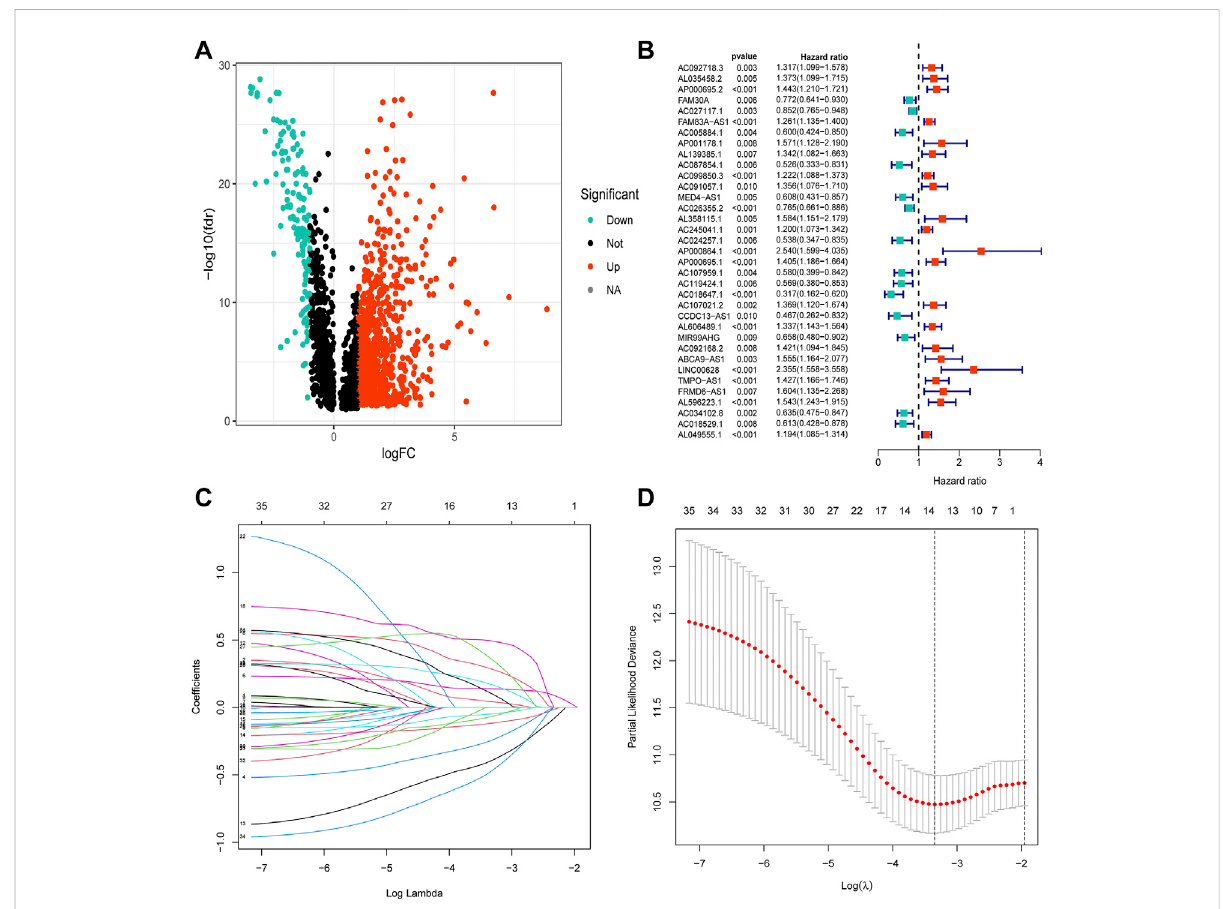
FIGURE 2 Construction of the necroptosis-related lncRNA prognostic signature. (A) The volcano diagram of 968 differentially expressed necroptosis- related lncRNAs. Red and blue colors represent upregulated and downregulated lncRNAs, respectively, in LUAD. (B) The hazard ratio (HR) and 95% con fi dence interval of 35 necroptosis-related lncRNAs were calculated using the univariate Cox regression analysis. The red and blue colors representhazardousandprotectivefactors,respectively. (C) TheLASSOCoxanalysisofnecroptosis-relatedlncRNAsinthetrainingcohort.The LASSOCoxcoef fi cientofeachlncRNAassociatedwithOSisrepresentedasacurve. (D) Thevalueofthepenaltyparameter( λ )wasdeterminedbased on the minimum partial likelihood deviationby 10-fold